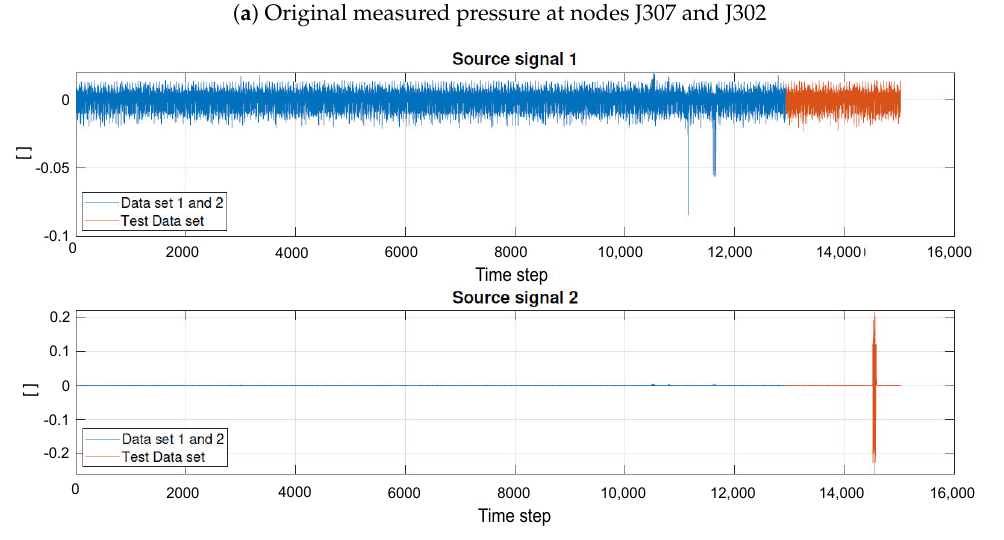
Figure 3. Comparison between mixed and separated pressure signal—combination